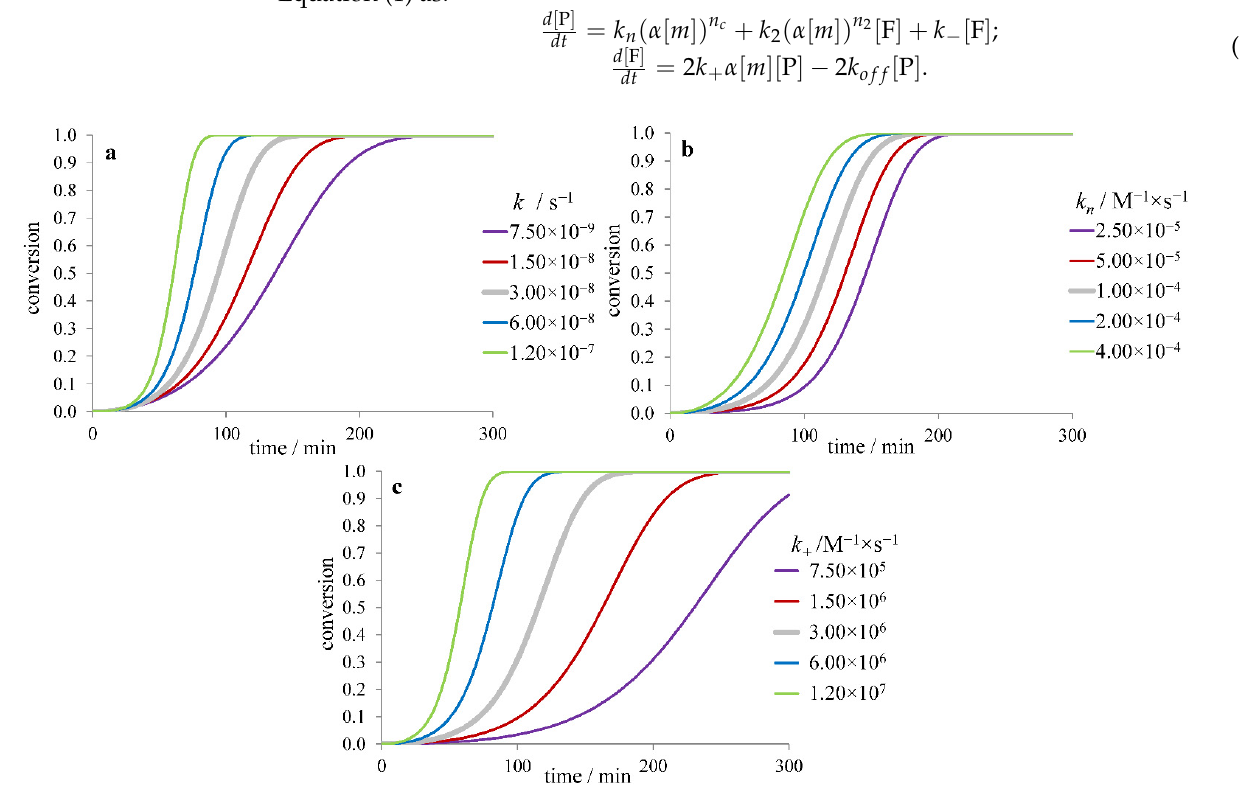
Figure 4. Dependence of the fibril formation time course on ( a ) fragmentation ( k − ), ( b ) nucleation ( k n ), and ( c ) elongation ( k + ) rate constant for the model with fragmentation and no secondary nucleation.